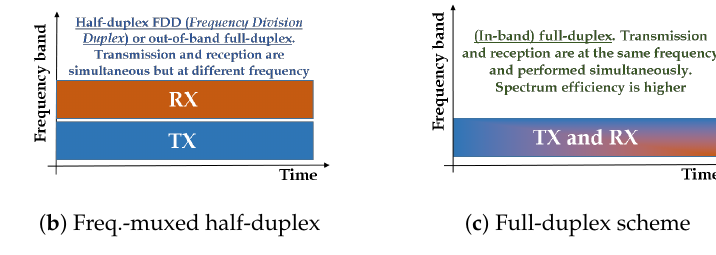
Figure 1. Communication